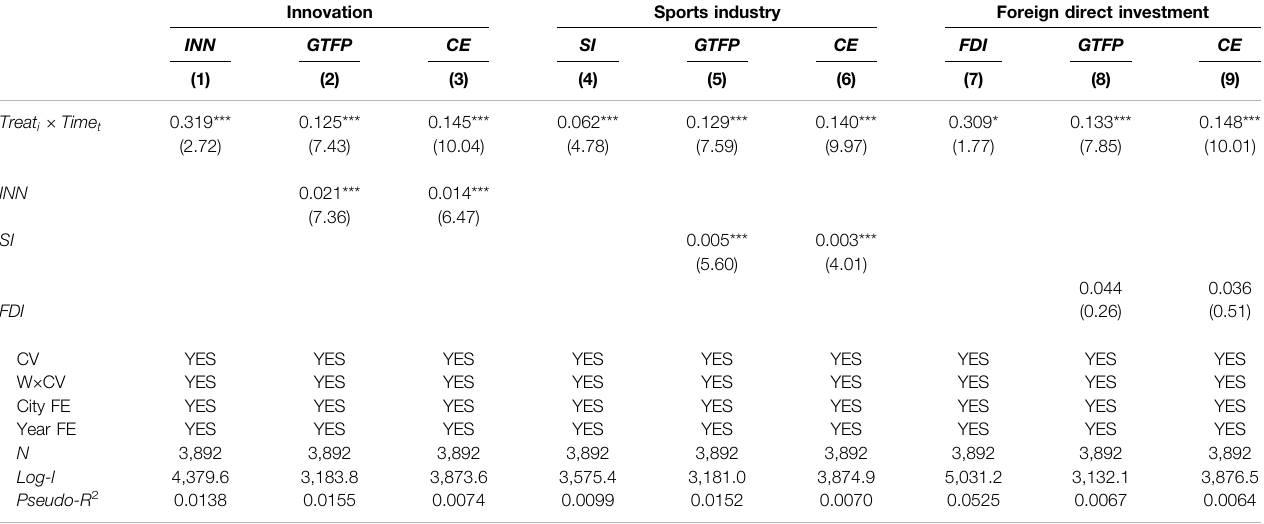
TABLE 8 | Mechanism identi fi